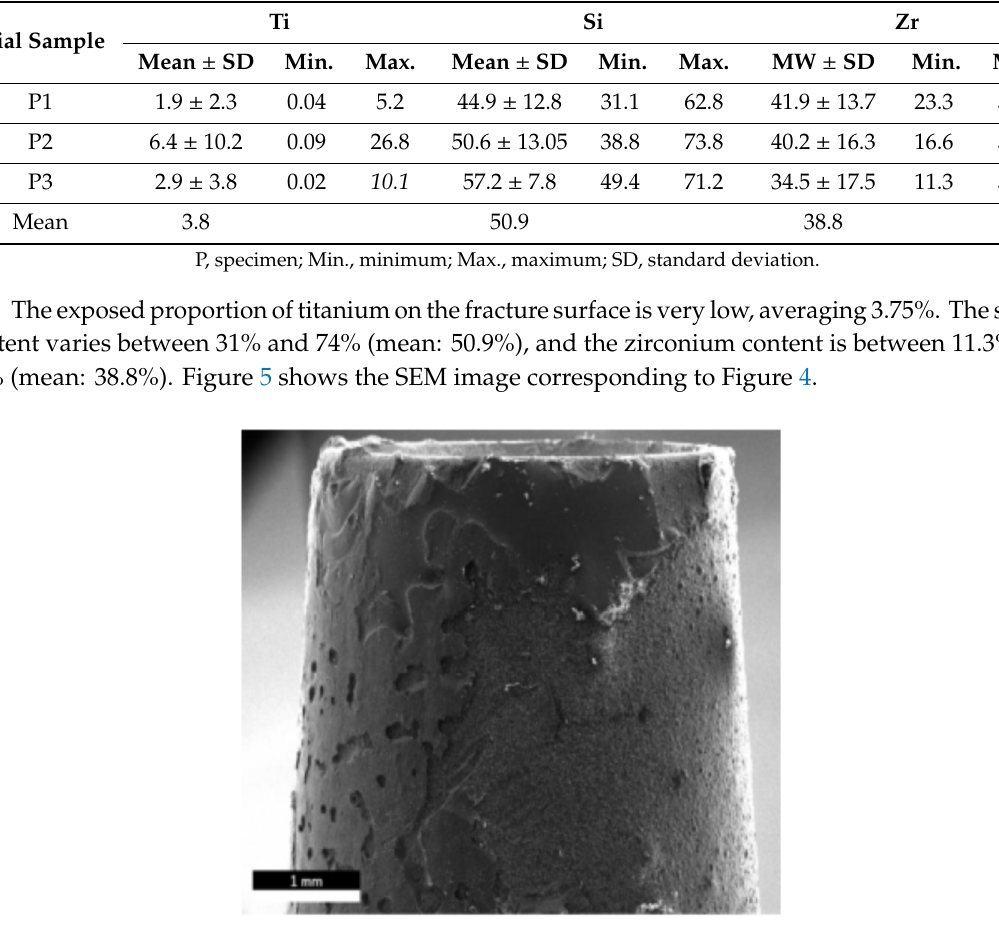
Figure 4. Distribution of the elements titanium ( a ), silicon ( b ), and zirconium ( c ) by energy-dispersive X-ray spectroscopy (EDX)-mapping. Bright areas indicate higher element concentrations.